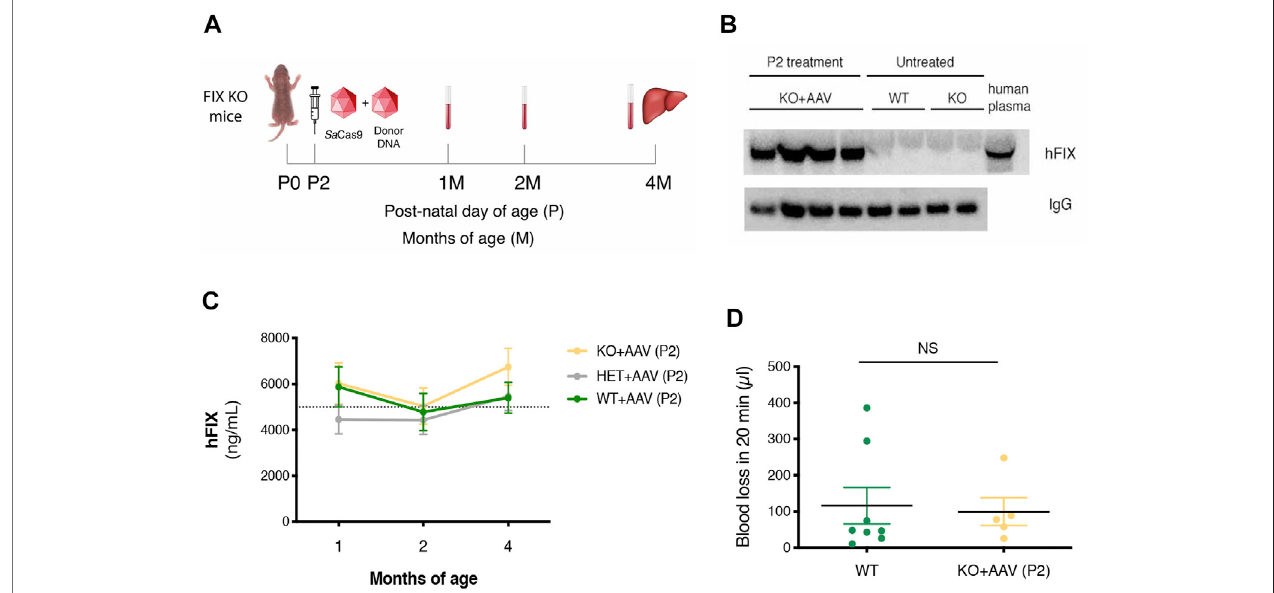
FIGURE2| TargetingthehFIXcDNAintothealbumin locusofneonatalFIXKOmice. (A) Experimentaldesign.FIXKOneonatalmicewereinjectedatpostnatal day (P) 2 with 0.6E11 vg/mouse of AAV8-SaCas9 and 5.0E11 vg/mouse of AAV8-donor-hFIX. Bleeding was performed at 1, 2 months (M) and mice were sacri fi ced at 4 months. The liver was collected for molecular analysis; (B) hFIX plasma levels (ng/ml) at 1, 2, and 4 months of age in WT ( n = 11), Het ( n = 6) and FIX KO ( n = 15) mice transduced with Sa Cas9 and donor-hFIX treated at post-natal (P) day 2. 5,000 ng/ml corresponds to the normal FIX plasma levels in healthy individuals in the human population; (C) Western blot analysis ofplasma hFIX in treated FIX KO mouse plasma. Untreated WT and KO mice were used as negative controls, while human plasma was used as a positive control; (D) Tail-bleeding assay. The coagulation time was evaluated in neonatally-treated FIX KO mice ( n = 5) and their wild-type littermates ( n = 8). Data are shown as mean ± SEM and analyzed by one-way ANOVA with Tukey ’ s multiple comparison test.